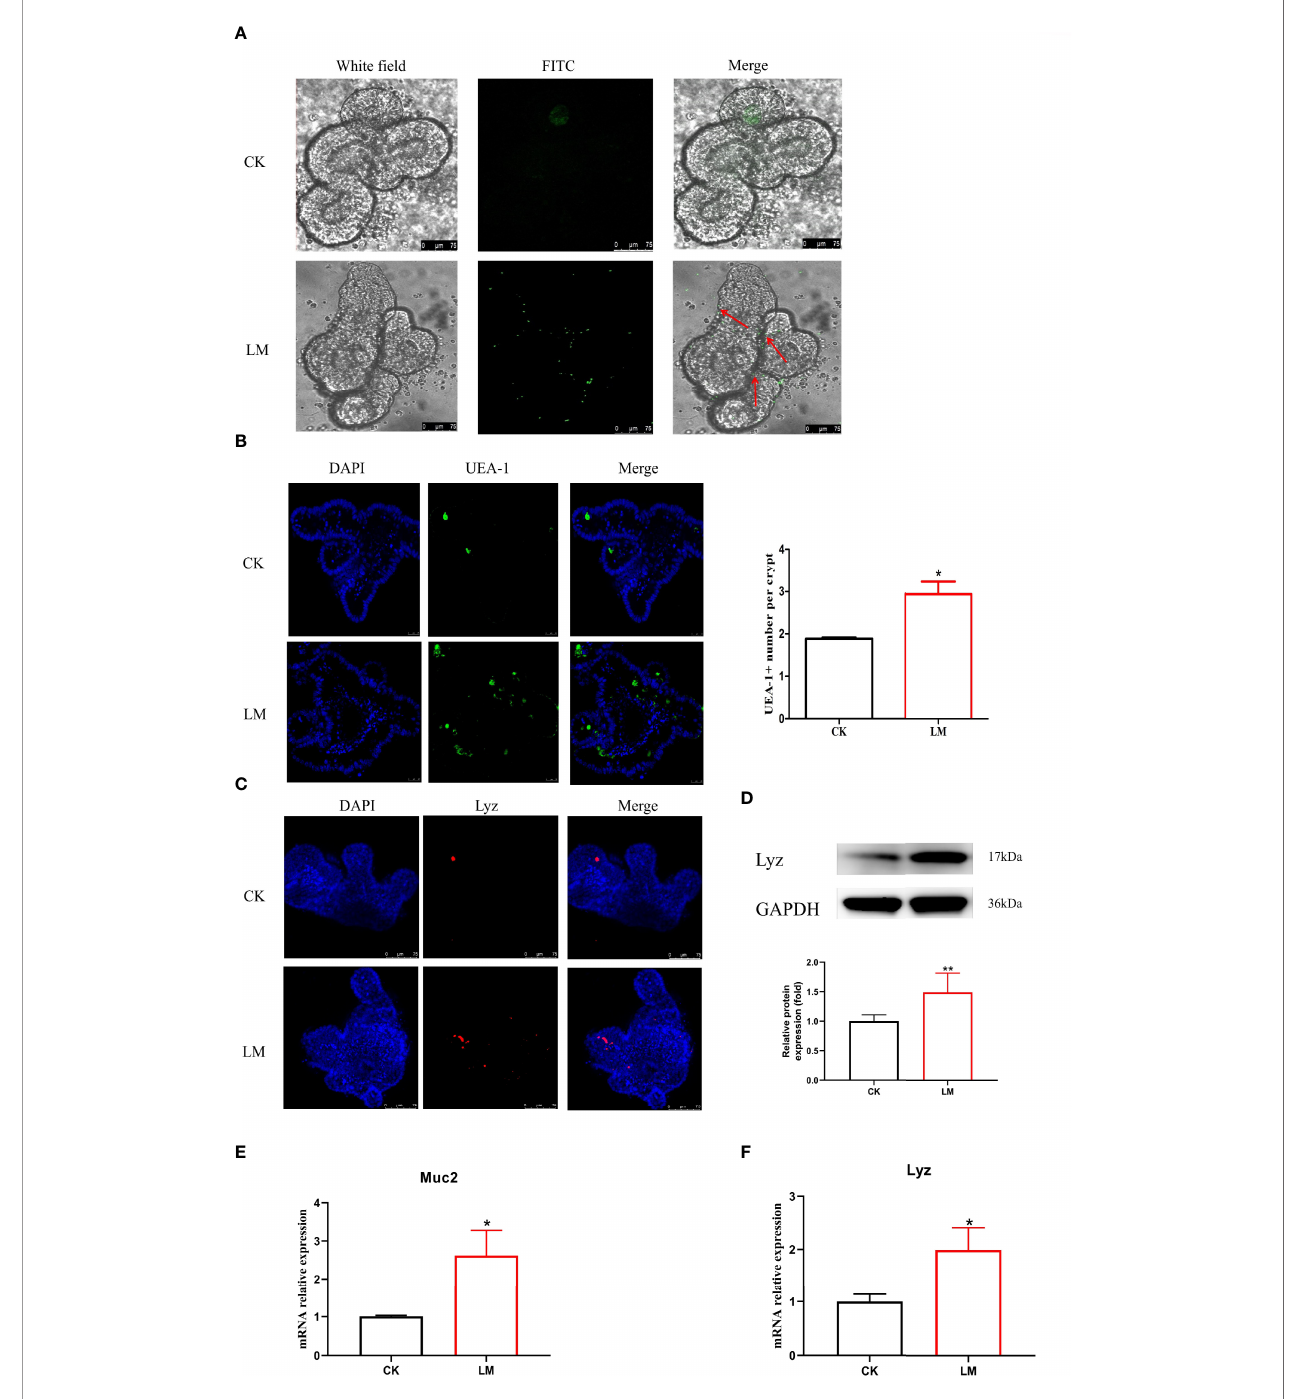
FIGURE 4 | The in fl uence of L. monocytogenes on the differentiation of intestinal secretory cells. CK, control; LM, L. monocytogenes-infected group. (A) The location of L. monocytogenes in organoids. (B) Confocal microscopy analysis of UEA-1+ cells in organoids. (C) Confocal microscopy analysis of Lyz+ cells in organoids. (D) Western blot of lysozyme in organoids. (E) mRNA levels of Muc2 from organoids samples. (F) mRNA levels of Lyz from organoids samples. Data is presented as mean ± SD. * P < 0.05, ** P < 0.01. Data combined from at least three independent experiments unless otherwise